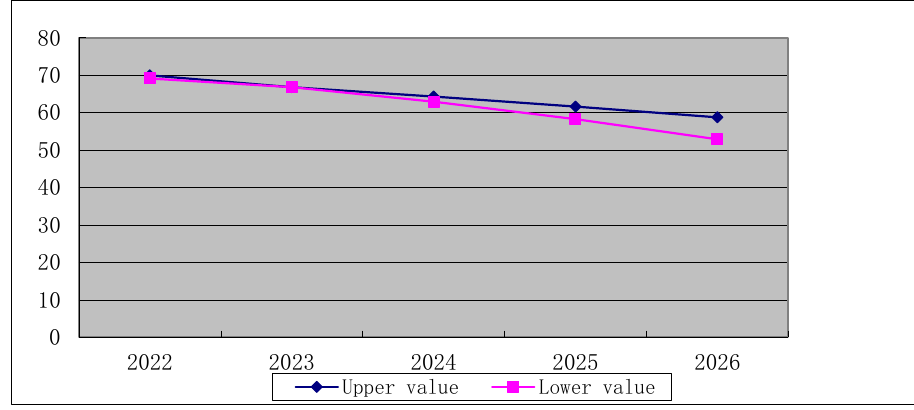
Figure 17. The variation interval of water requirement with the influence of population in Shanxi Province.